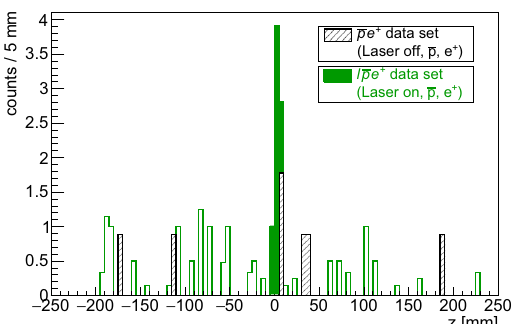
Fig. 4 Distribution of the z -coordinates of tracks reconstructed with the fast cryogenic detector (FACT). The plot shows the distribution of the z - coordinates of charged particle tracks reconstructed from hits detected in the two layers of the FACT detector in temporal coincidence ( Δ t = ±5 ns) with hits of the external detector scintillator array (ESDA). For this combined analysis, we used a mean ESDA amplitude of 150 mV, lower than that used in the ESDA-only analysis. The antiproton plasma is centered at z = 0. The distributions for the two samples are rescaled to the same number of antiprotons; furthermore, each track is weighted to account for combinatorial ambiguities (several hits may fi re in the same temporal coincidence window, particularly at early